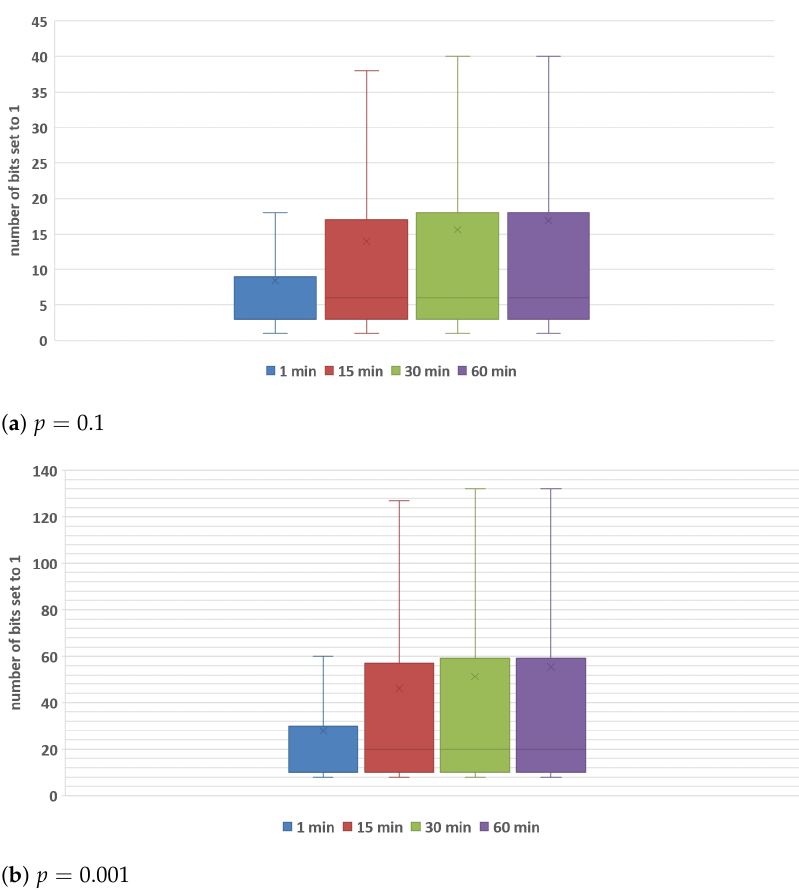
Figure 7. BF structure occupancy for different BF validity periods when n =